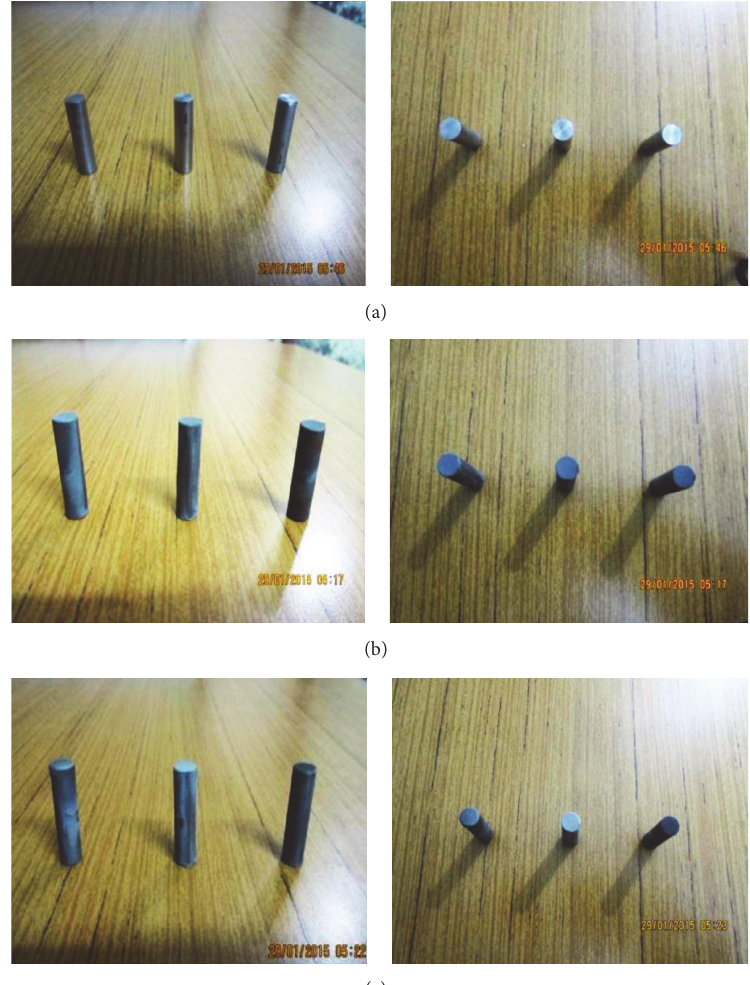
Figure 2: The figure shows the front view and top view (macrographs) of (a) uncoated or bare (ASTM A36) test specimens; (b) WC-12% Co coated pins; (c) Cr 3 C 2 -25% NiCr coated pins prepared for the sliding wear testing on pin-on-disc wear